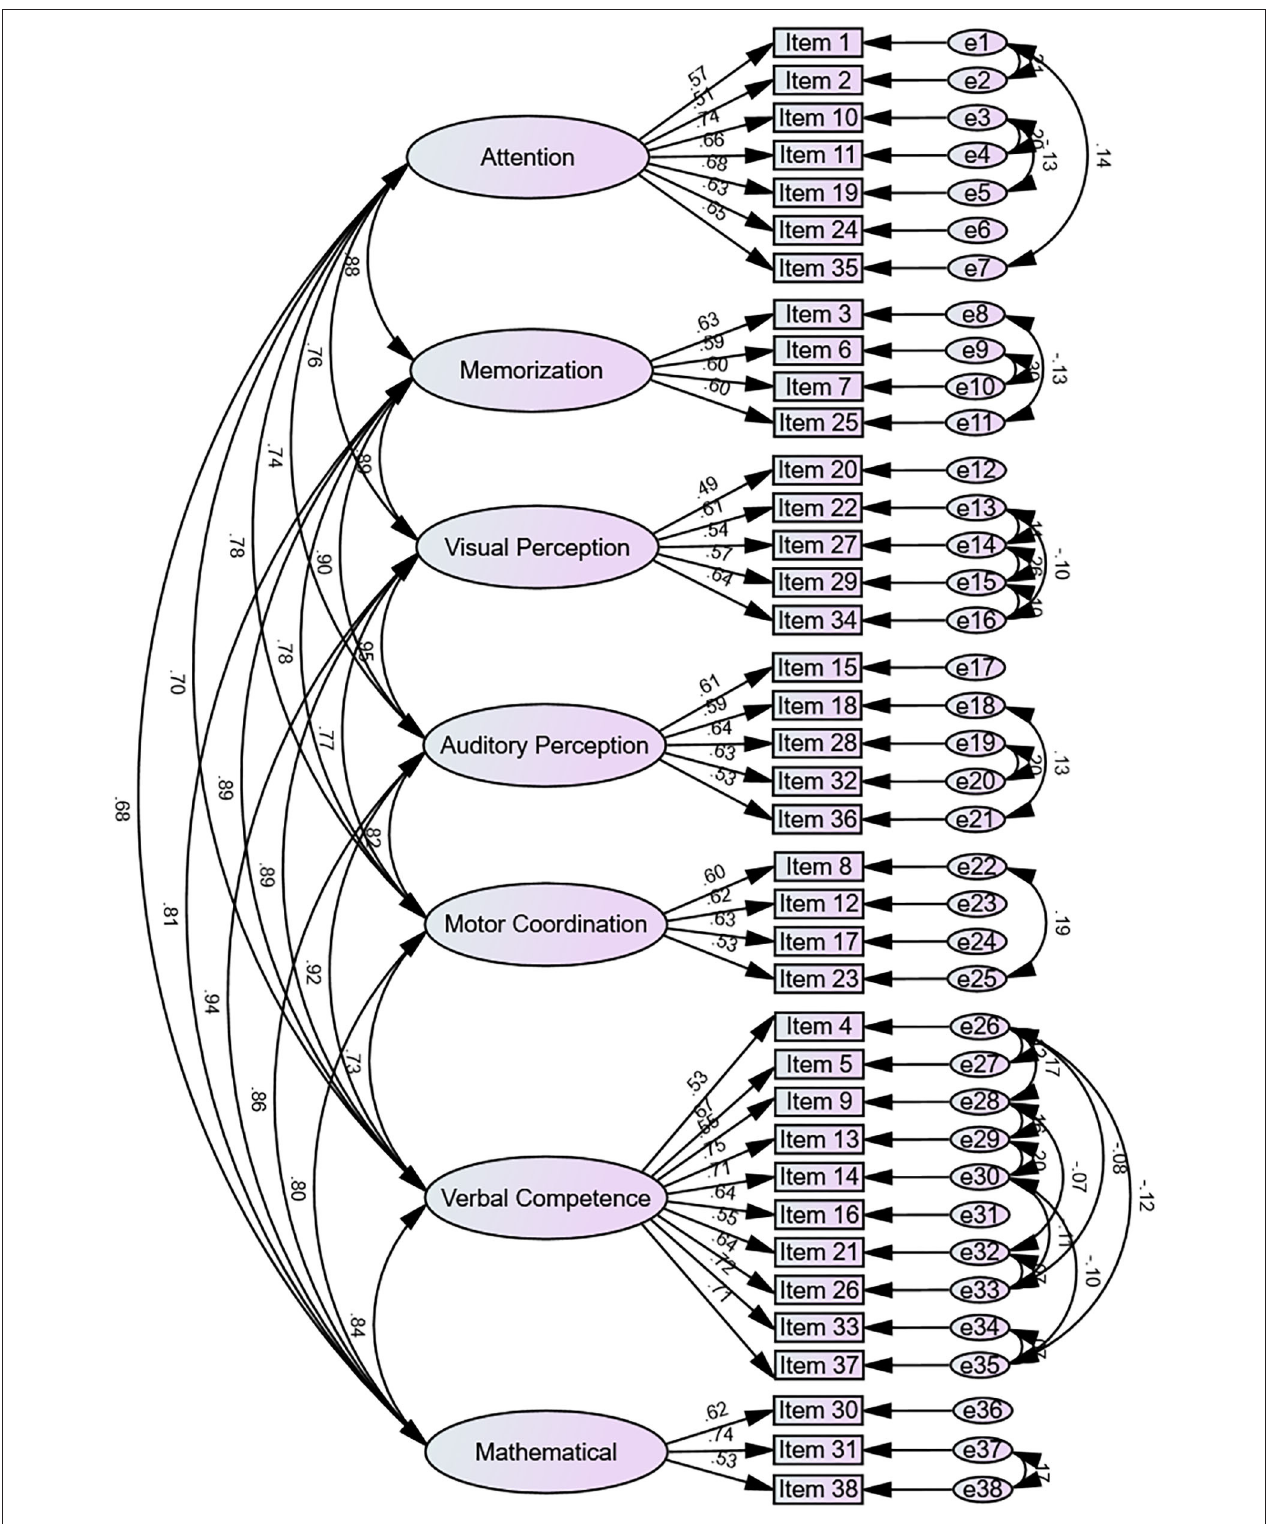
FIGURE 1 | The standardized path coefficients of the preschool learning skills scale ( n = 1,137).